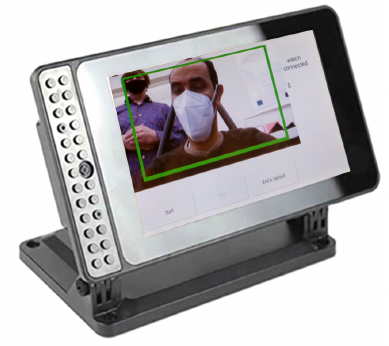
Figure 6. The student hardware module.